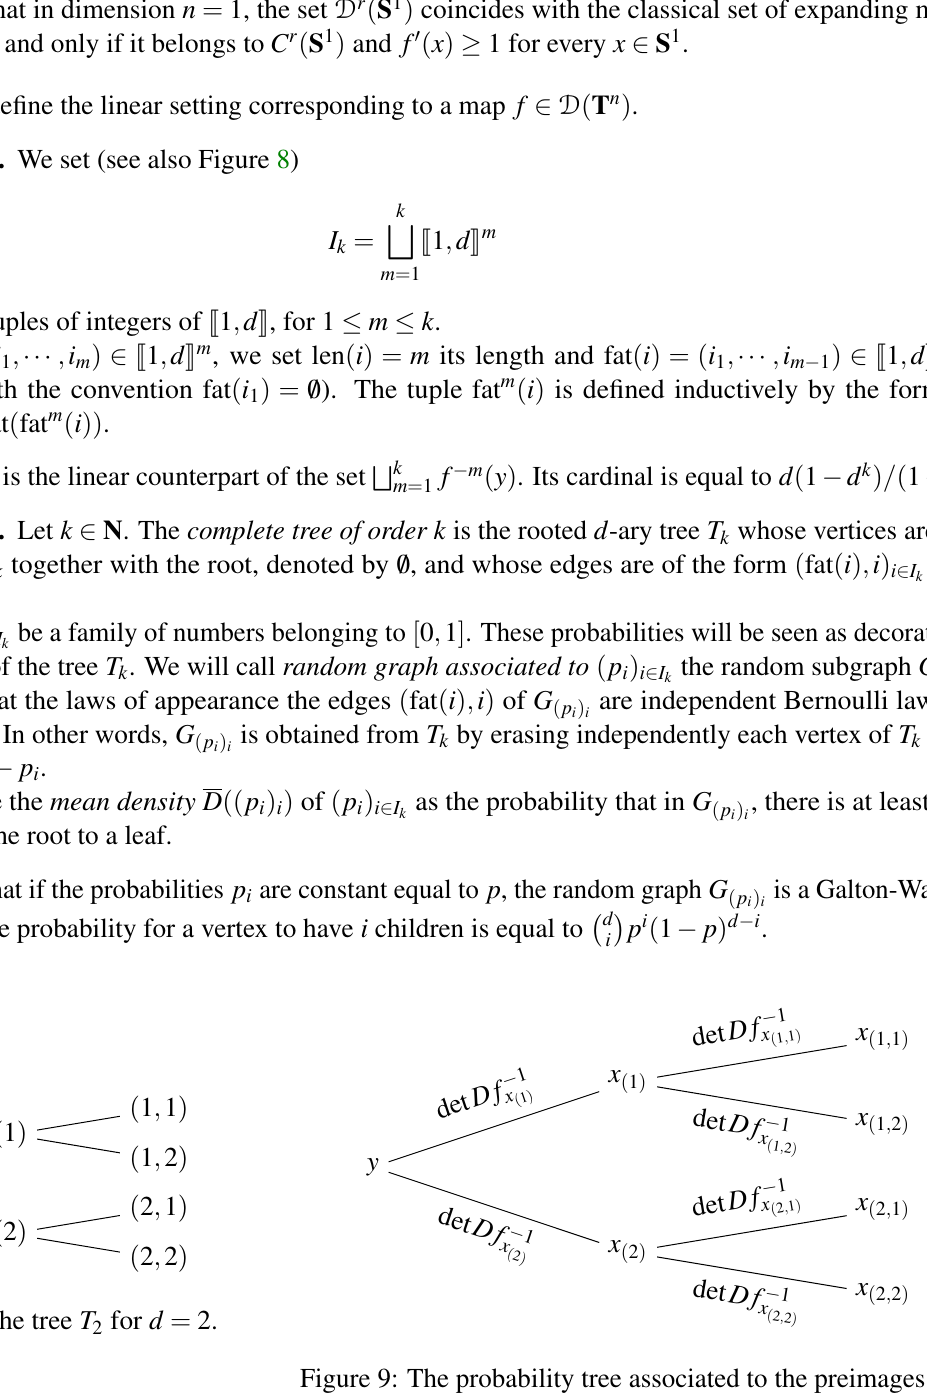
) = f ( x ) = x , etc. ( 1 , 1 ) ( 1 , 2 ) ( 1 )